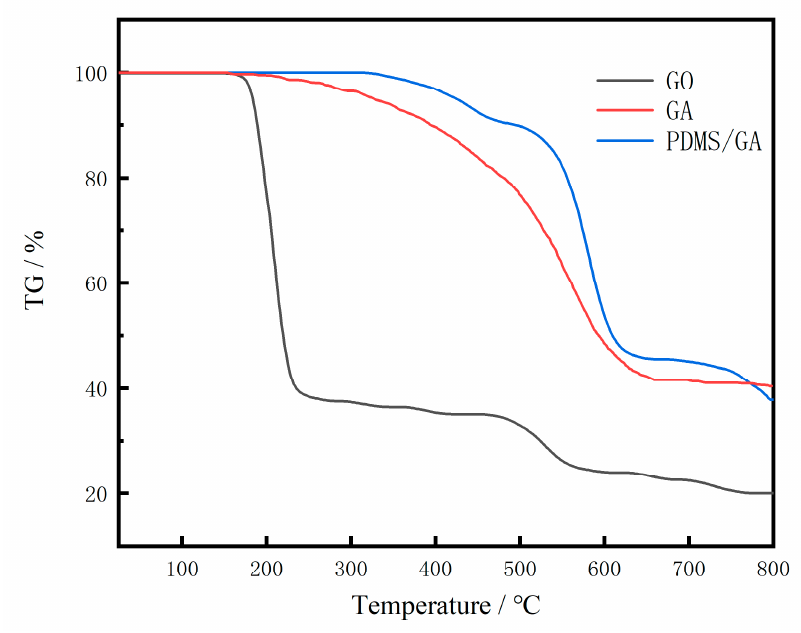
Figure 4. The GO of raw GO, GA, and PDMS/GA.